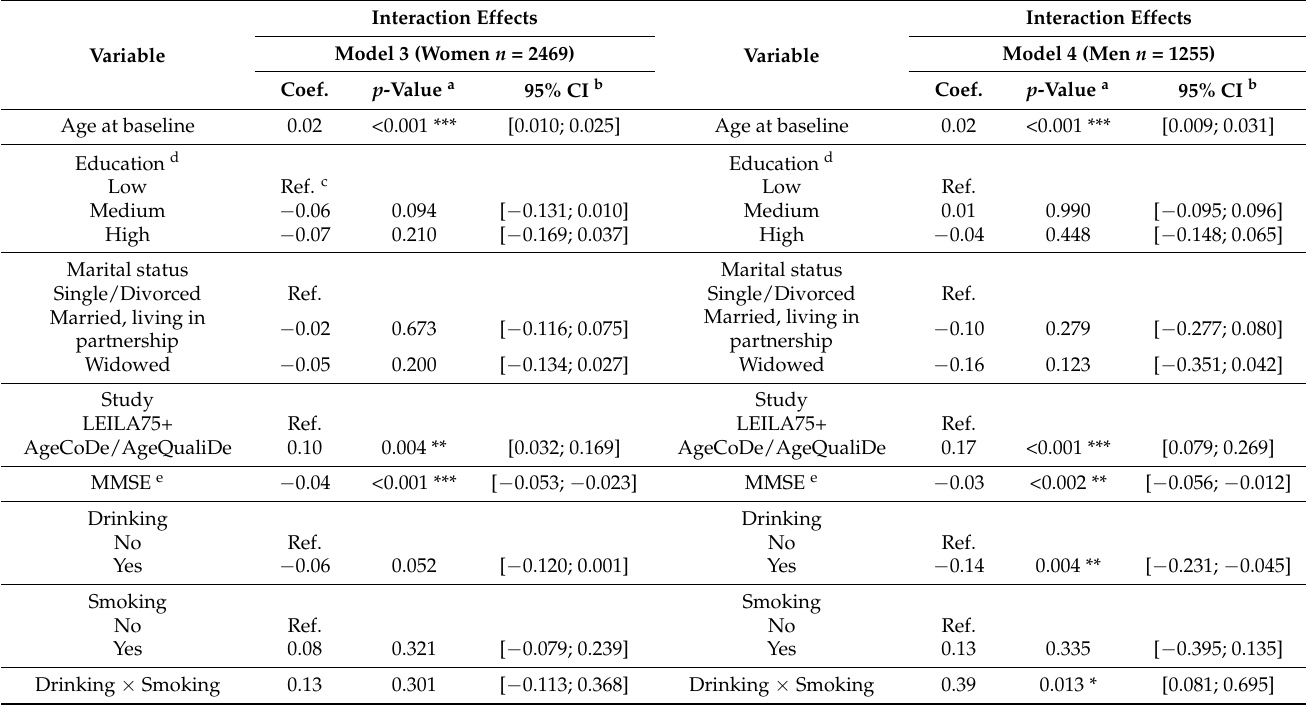
Table 4. Linear mixed-effects regression with the harmonized depression scale stratified for